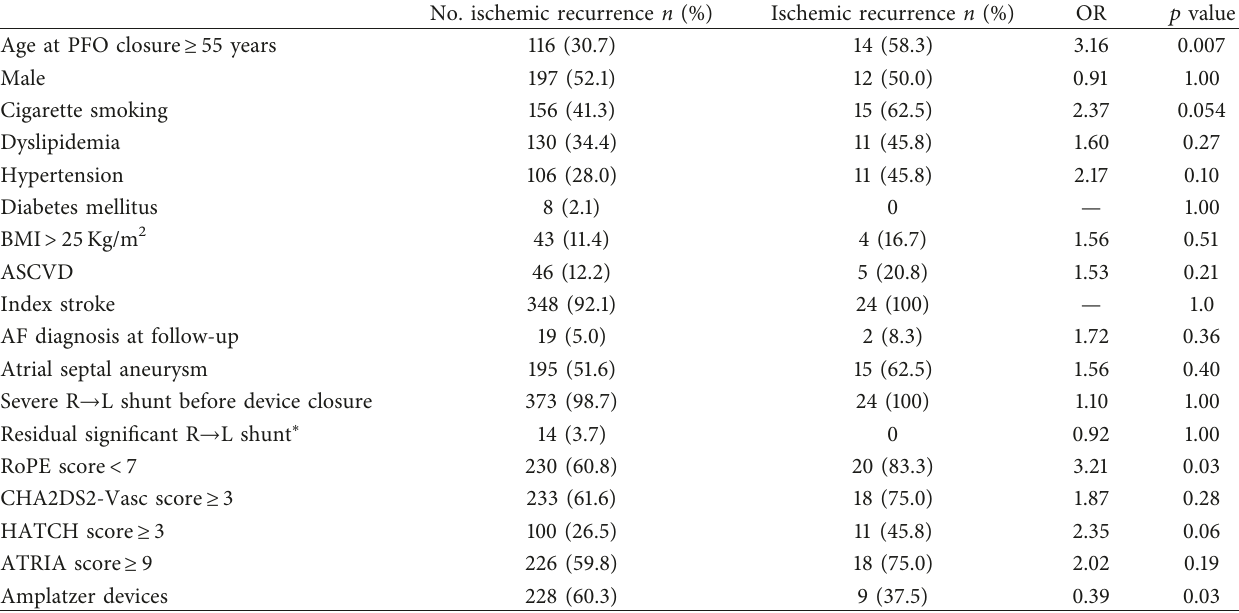
Table 4: Predictors of recurrent ischemic neurological events.